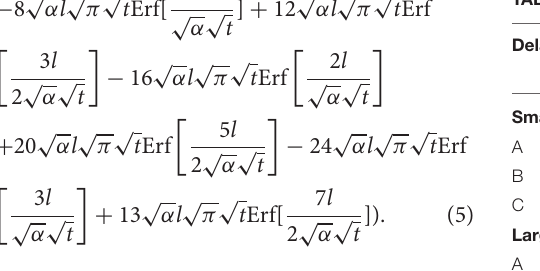
TABLE 2 | Comparison of thermal to X-ray CT for damage